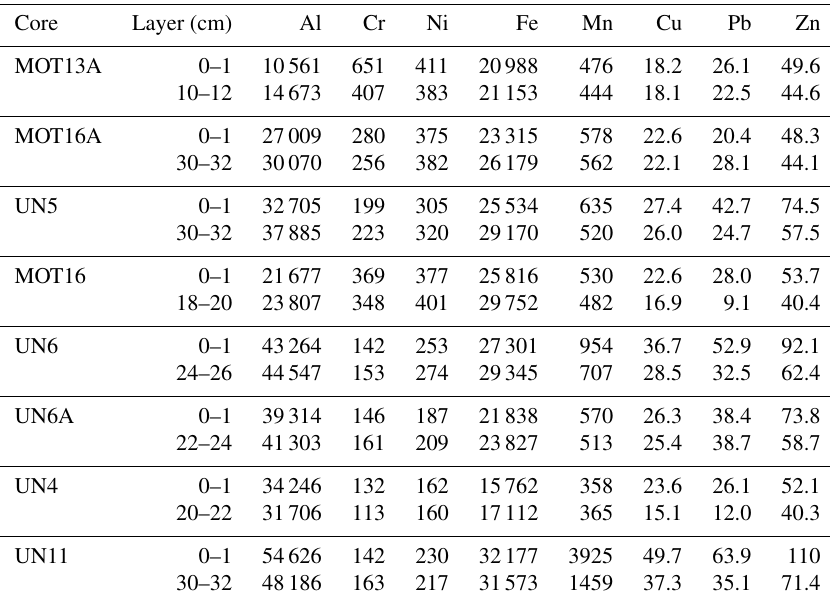
Table 4. Concentrations (in mgkg − 1 ) of metals at the surface and in the deeper sediment layer of cores. The concentrations at coarse-grained cores MOT13A, MOT16, UN4 refer to the fine-sediment fraction ( f <